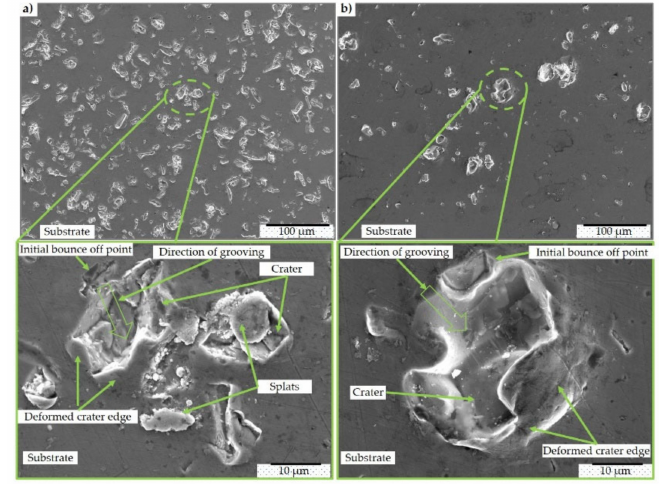
Figure 5. The e ff ect of the size distribution of mixed in hard particles on the splat formation: ( a ) Al 2 O